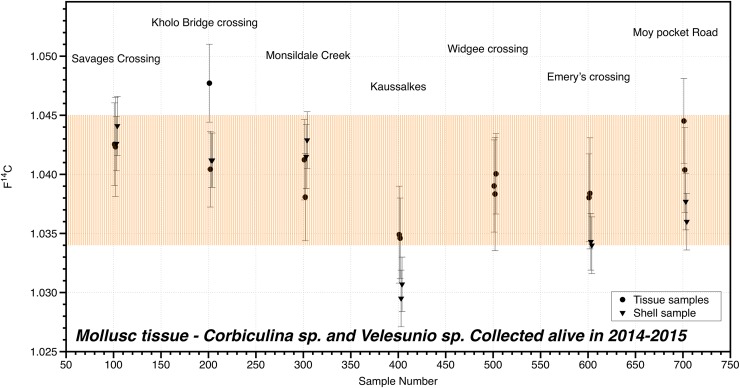
F14C of lungfish food.F14C values for mussel tissue and shell material from 7 locations. The highlighted box shows the range (2012–2015, due to mussels living for several years) in the atmospheric F14C CO2 for comparison.